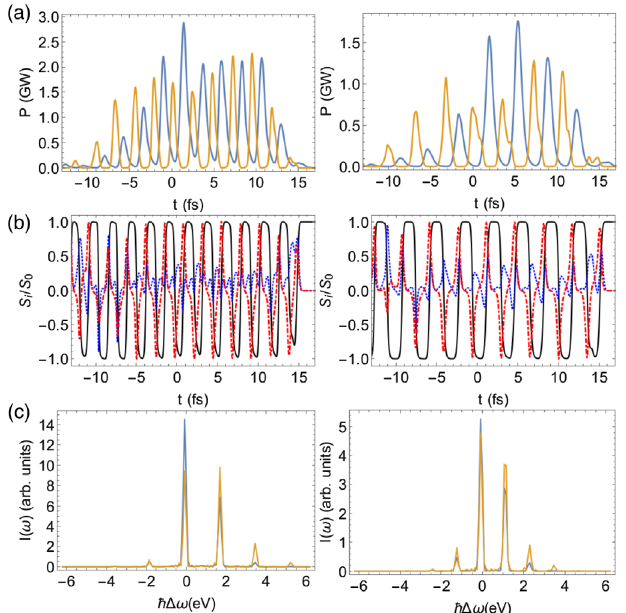
FIG. 6. Temporal modulation produced with single color enhanced self-seeding plus current modulation. Left: 700 nm modulation Right: 1050 nm modulation. Top: power in s -polarization (blue) and p -polarization (yellow). Middle: nor- malized Stokes parameters, S 1 =S 0 (black, line), S 2 =S 0 (blue, dotted), S 3 =S 0 (red, dashed). Bottom: on-axis spectral intensity in s -polarization (blue) and p -polarization